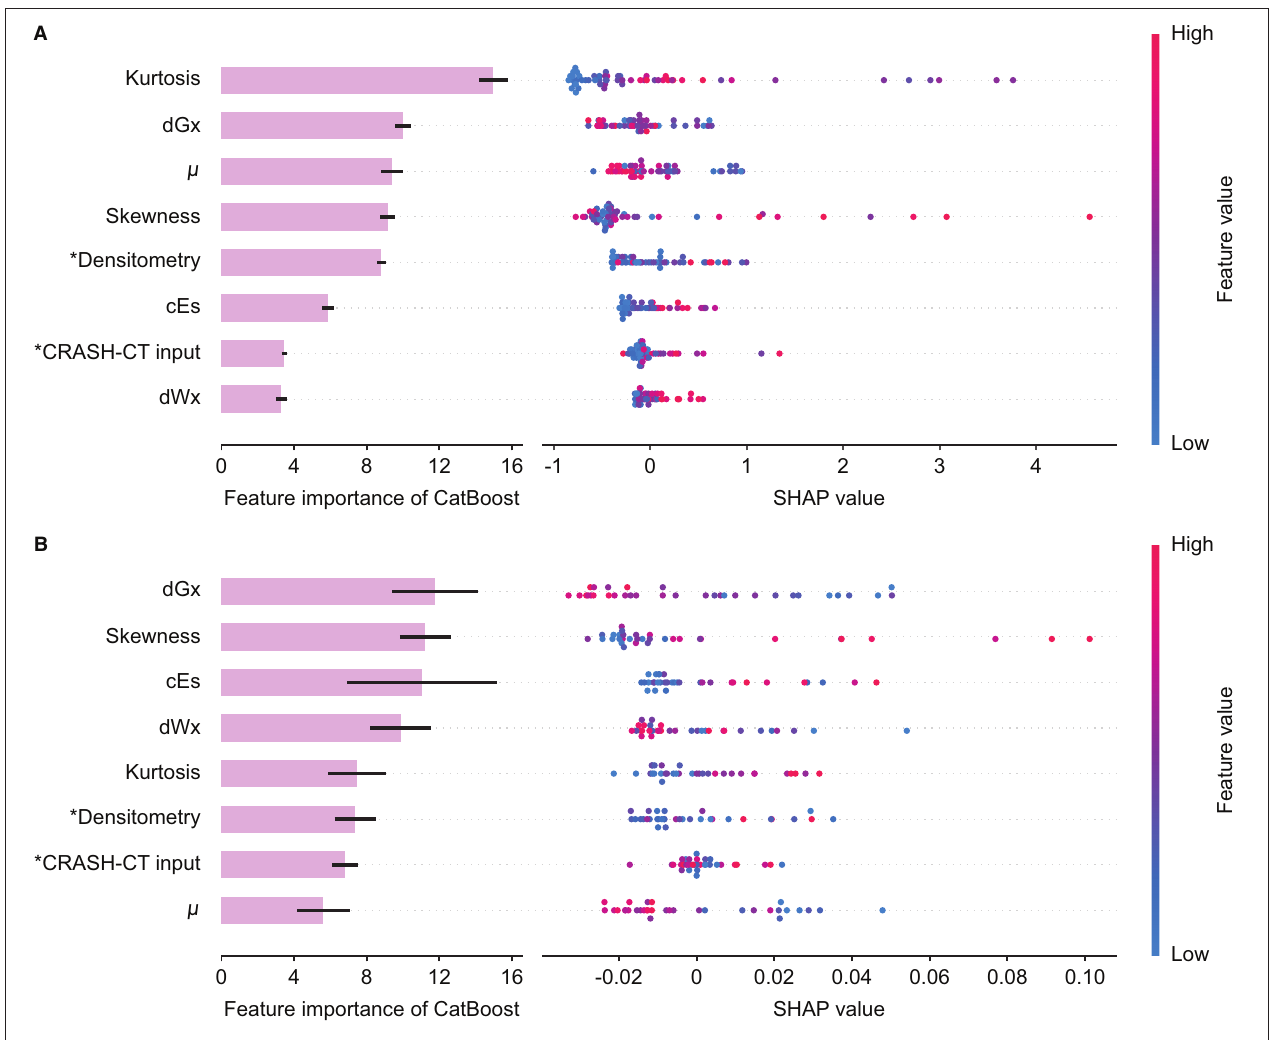
FIGURE 5 | Feature importance and SHAP value of the D/CRASH-CT CatBoost model for the differentiation of favorable and unfavorable outcomes based on the initial brain CT at admission (A) and follow-up brain CT within 48h (B) . Each row shows the distribution of SHAP values assigned to a model input. Asterisks denote input variables that have undergone dimensionality reduction by principal component analysis.